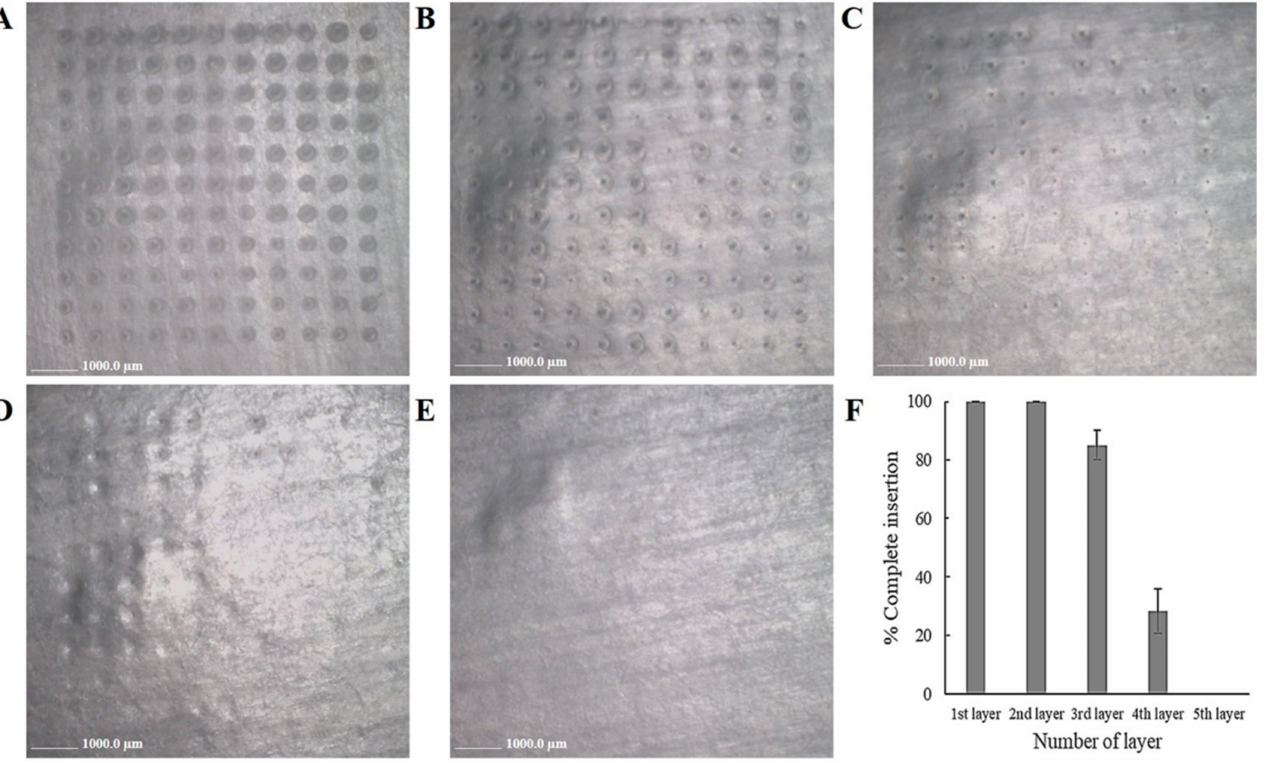
Figure 6. Images of complete insertion into artificial membrane (Parafilm M ® ) of FLUZ-MEs-loaded two-layered dissolving MNs: ( A ) 1st layer; ( B ) 2nd layer; ( C ) 3rd layer; ( D ) 4th layer; ( E ) 5th layer; and ( F ) percentage of complete insertion versus number of